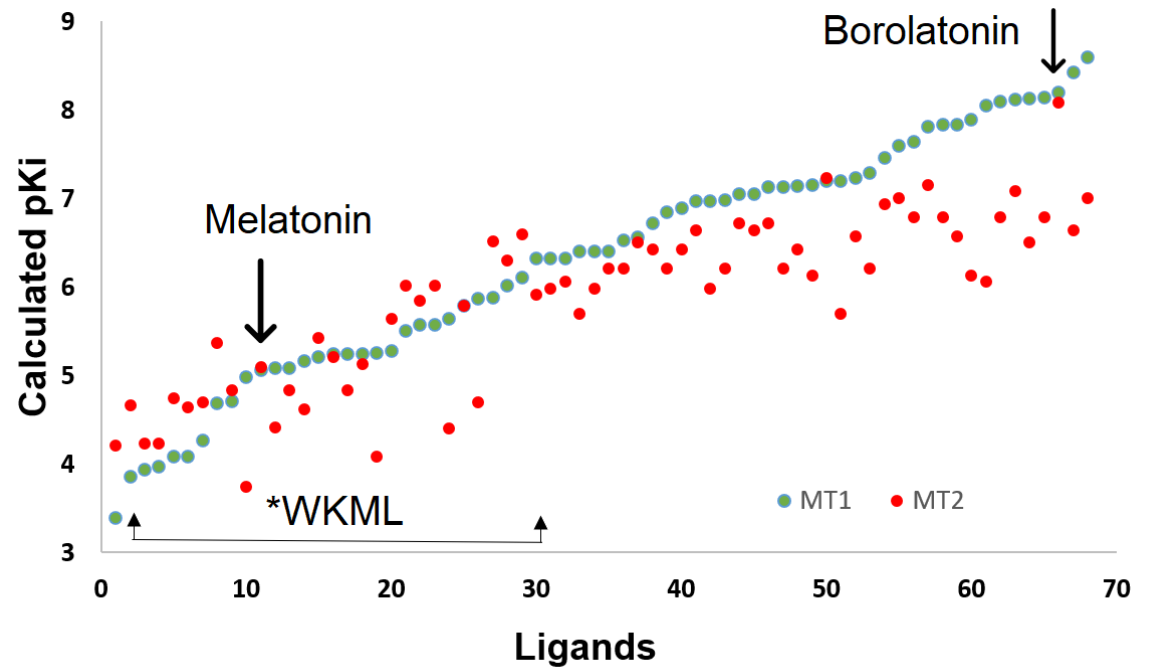
Figure 7. Affinity of tested ligands on human melatonin receptors. Arrows are for labeling the endogenous agonist melatonin, the tested compound borolatonin, and a region for predicted affinity values for the well-known melatonin-receptor ligands (*WKML).